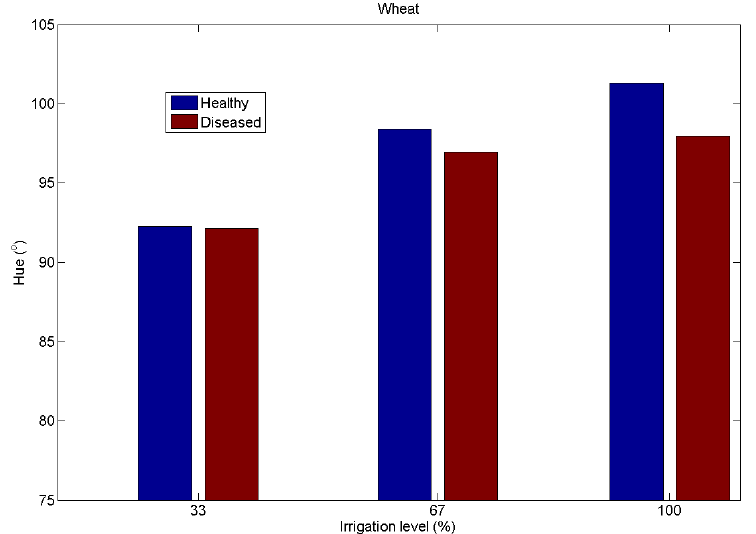
Figure 7. EM-determined seasonal averages of vegetation hues for different treatments in 2011.